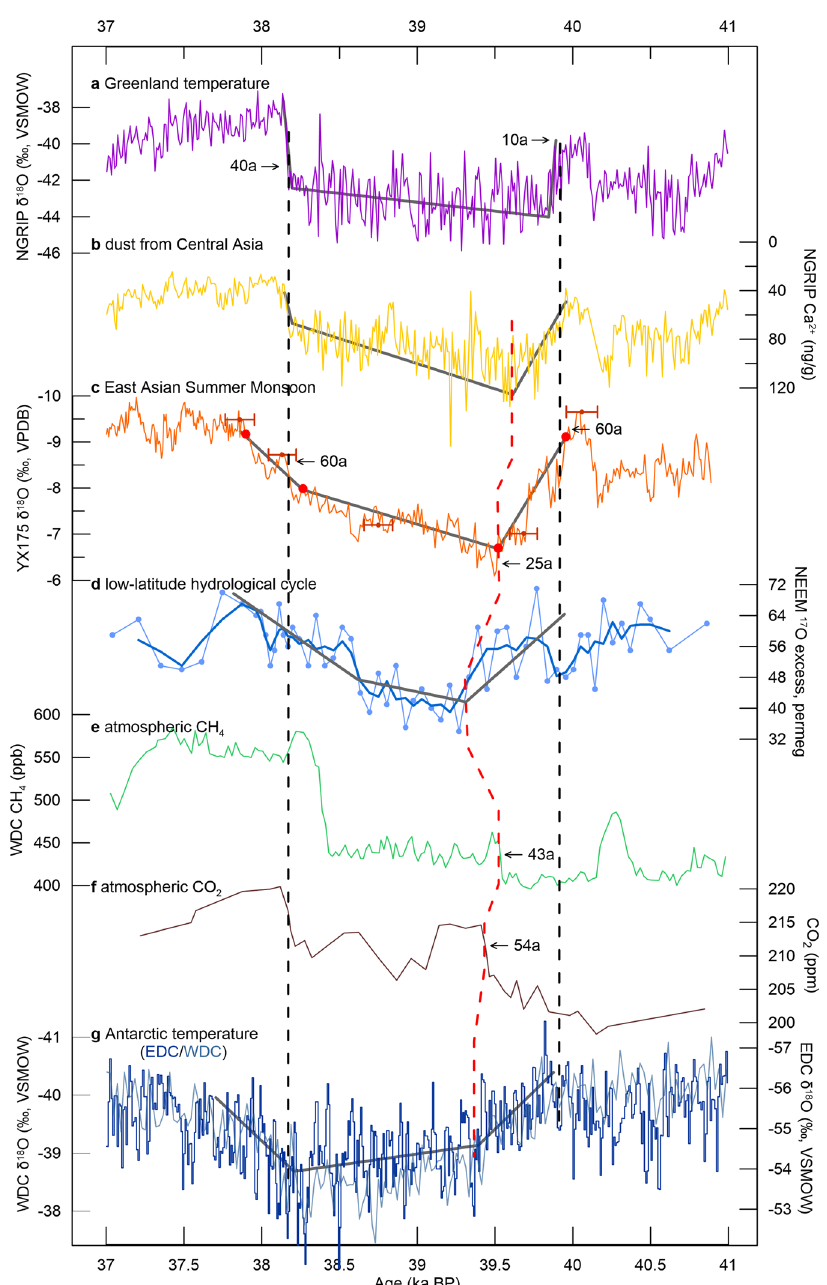
Fig. 2 Detailed view of the HS4 (AIM8) Structure. a δ 18 O ice (purple) 1 and b dust Ca 2 + (yellow) 44 records from NGRIP ice core on the GICC05 chronology 86 . c YX175 δ 18 O calcite record and dating results with errors (orange). d NEEM 17 O-excess record (blue line and dots) 45 . e CH 4 records from WDC ice core on the WD2014 (green) 5,51 . f CO 2 record from Siple Dome (brown) 74 . g δ 18 O ice records from EDC ice core (navy blue) 7 on the AICC2012 chronology 87 and WDC ice core 5 (light blue) on the WD2014 chronology 51 . Black dashed lines indicate the onset and the end of the HS4 in NGRIP δ 18 O ice record, and the red one indicates the abrupt shifts in proxies. Five bold black polylines depict the structure of HS4 (AIM8). Phase division in Antarctic records in f follows 7 . Duration of rapid shifts in proxies are